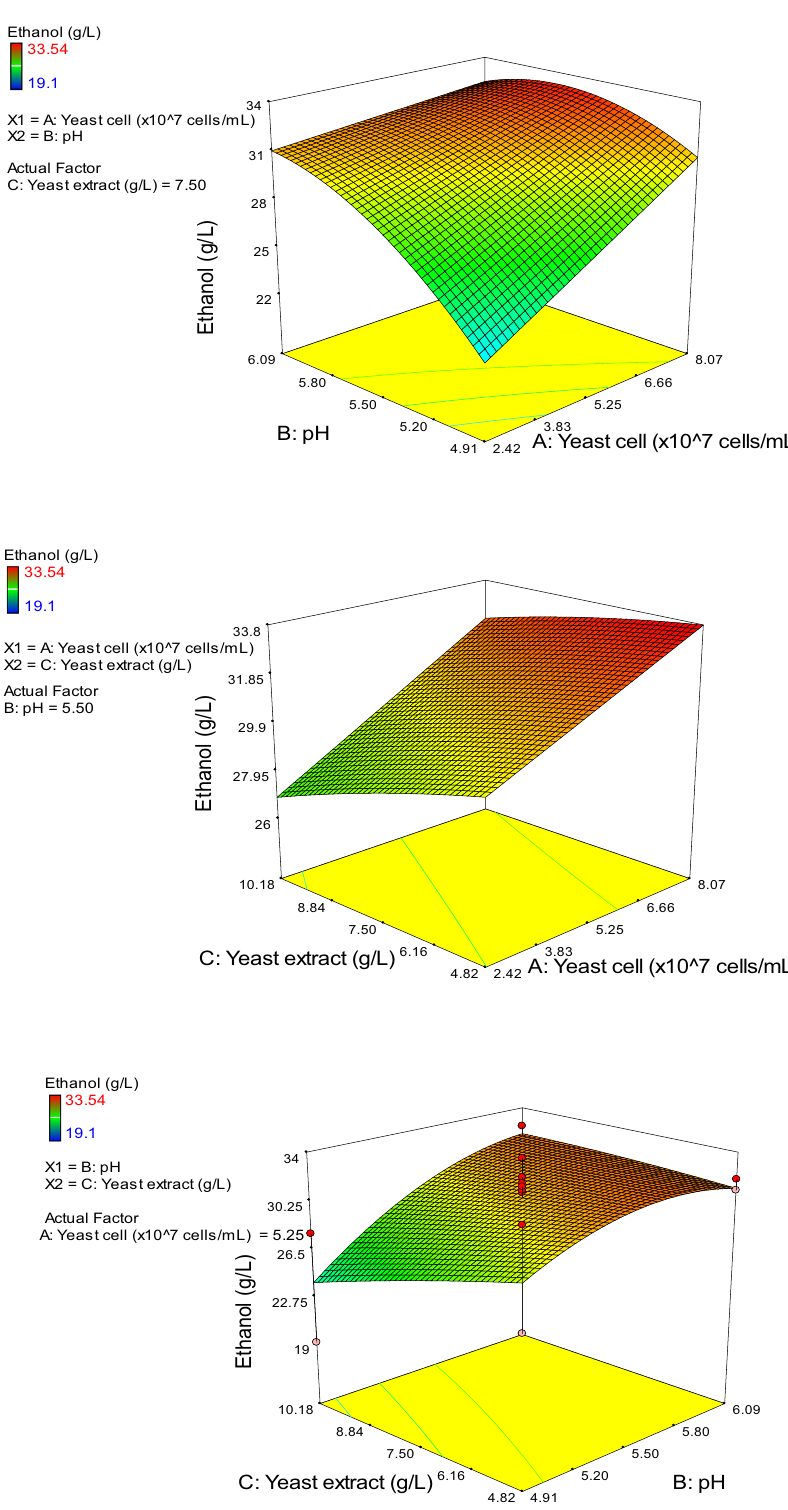
Figure 2. 3-D response surface plots showing the effect of cell concentration (A), pH (B), and yeast extract (C) on ethanol